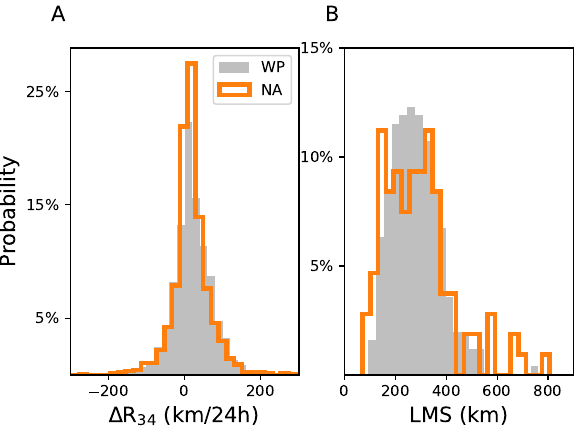
Figure 1. Distribution of ( A ) ∆ R 34 (units: km/24 h) and ( B ) lifetime maximum size (LMS, units: km) for the western north Pacific (grey) and north Atlantic TCs